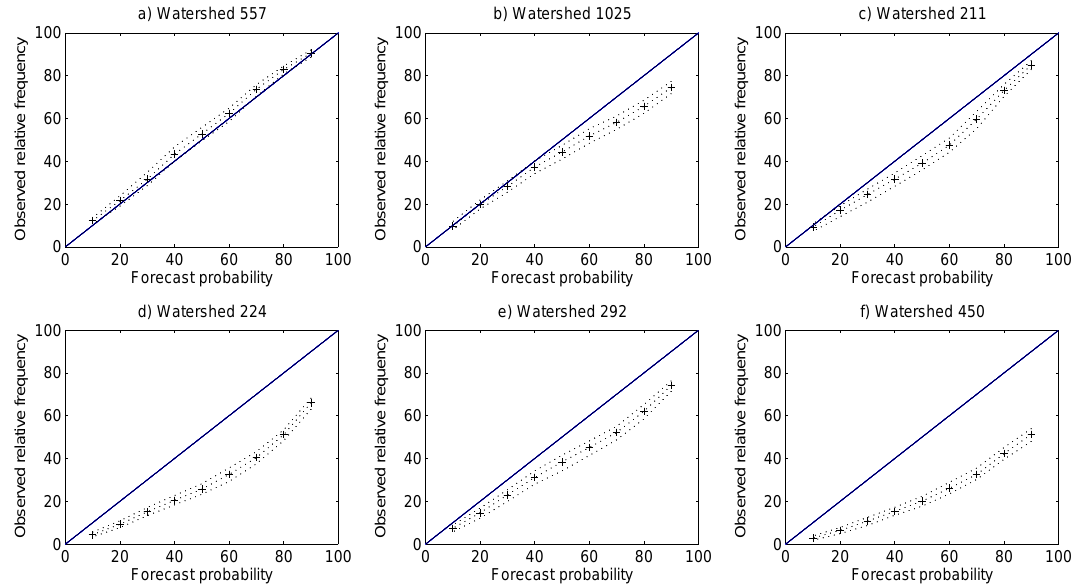
Fig. 6. Reliability plots for the same catchments as in Fig. 5, for all time series. Dashed lines depict the 95% confidence interval.